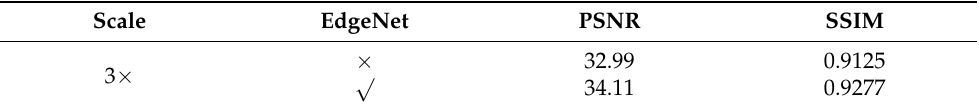
Table 3. Quantitative results of edge enhancement. We compared two different models (whether they contain EdgeNet) on the Set5 dataset for 3 ×